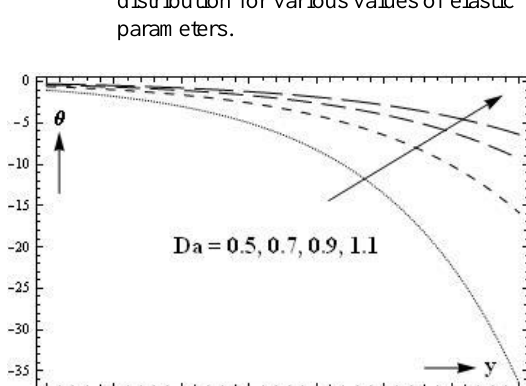
Figure 3. Variation of dimensionless temperature distribution for various values of slip parameter.